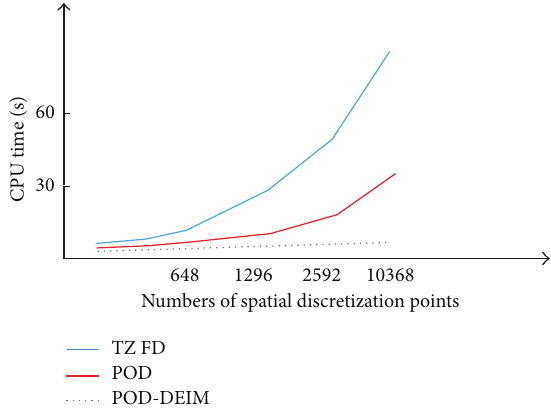
Figure 7: CPU time for TZ FD, POD, and